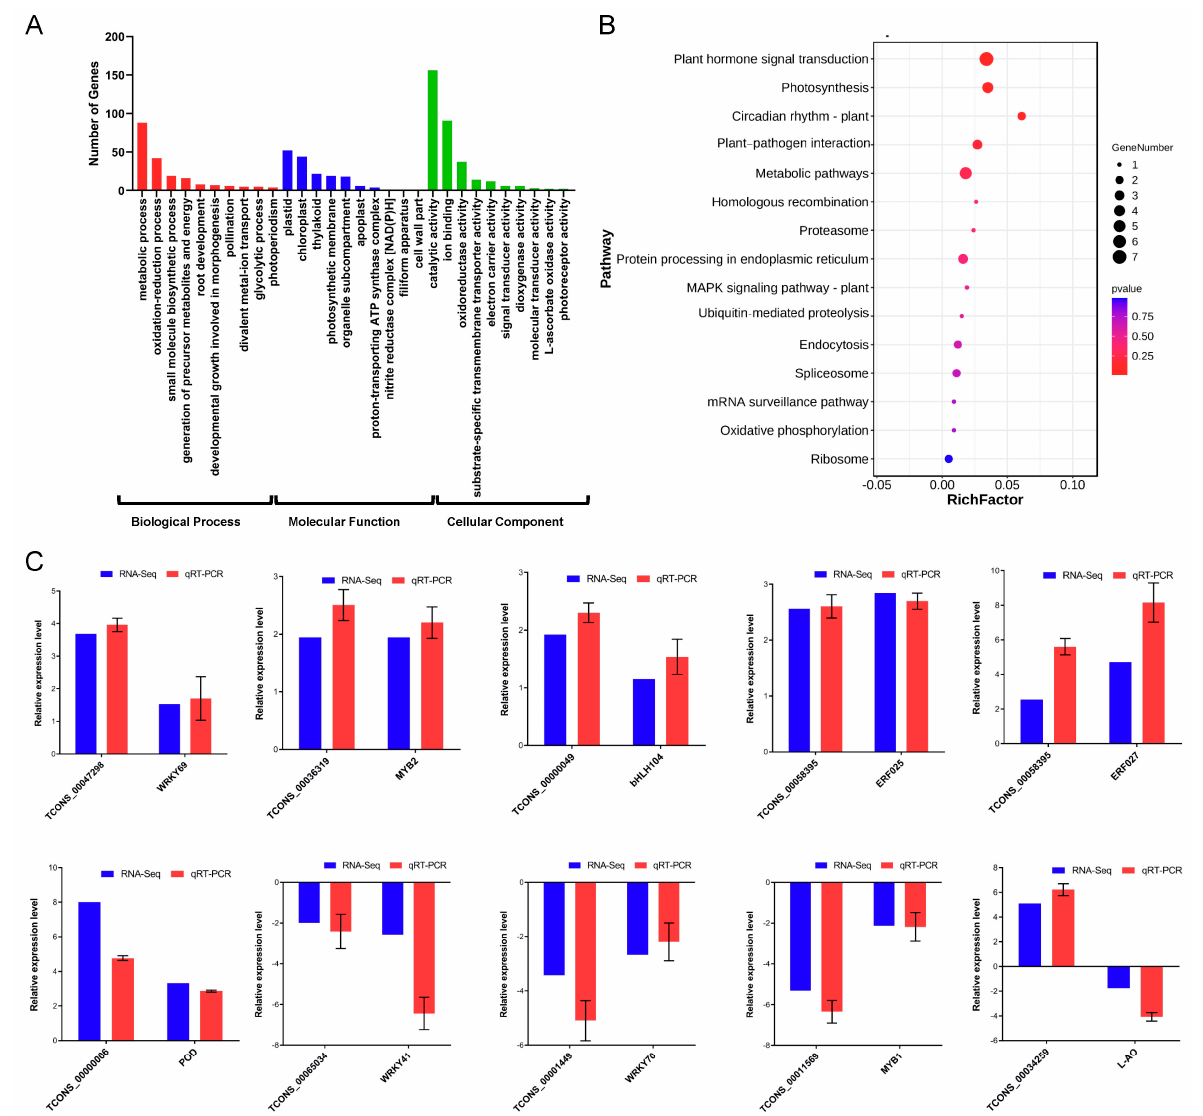
Figure 7. Functional analysis of cis-regulated lncRNA–mRNA pairs related to cold response. ( A ) GO classification of mRNAs. The x -axis indicates GO terms, and y -axis indicates the number of genes. The red bar charts represent the biological process, the blue bar charts indicate the molecular function, and the green bar charts represent the cellular component. ( B ) KEGG pathway analysis of mRNAs (top 20). The x -axis represents the percentage of genes, and the y -axis indicates the pathways. ( C ) qRT-PCR verifies the expression patterns of 10 cis-regulated lncRNA–mRNA pairs under cold stress.